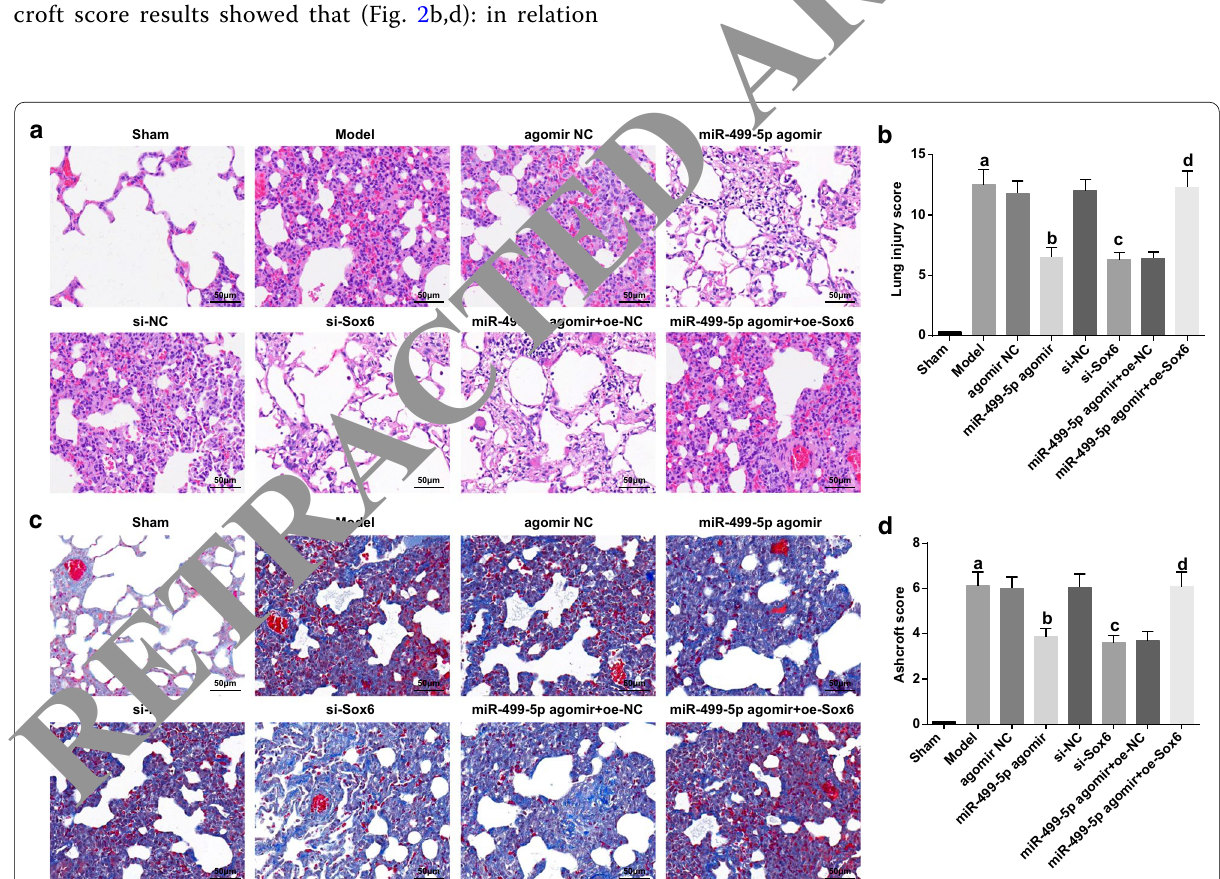
Fig. 2 Restored miR-499-5p or depleted Sox6 alleviates lung tissues pathology, reduces lung injury score, collagen fibers and the degree of pulmonary fibrosis in sepsis-induced lung injury mice. a Results of HE staining in lung tissues of mice. b The lung tissue injury score of mice in each group. c Masson staining of lung tissue in mice. d The pulmonary fibrosis scores of mice in each group. (a) P < 0.05 versus the sham group. (b) P < 0.05 versus the agomir NC group. (c) P < 0.05 versus the si-NC group. (d) P < 0.05 versus the miR-499-5p agomir data were depicted as mean standard deviation, and data were assessed by one-way ANOVA followed by Tukey’s post hoc ±